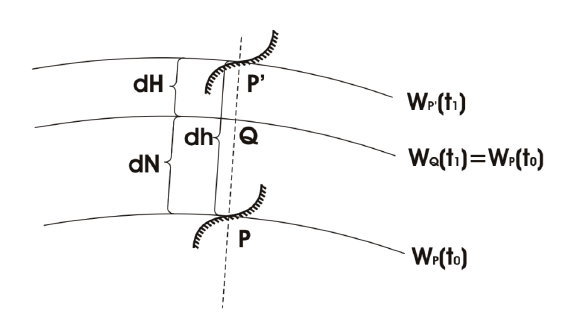
Figure 11. The effect of the time variation of the gravity field at the Earth’s surface. showsanarbitrarypoint P initsoriginalpositionattheEarth’ssur- facebeforethedisplacementattime t = t 0 . Thepotentialsurface, W = W P passes through the point. There is a displacement as- sumed to occur between t 0 and a subsequent time t 1